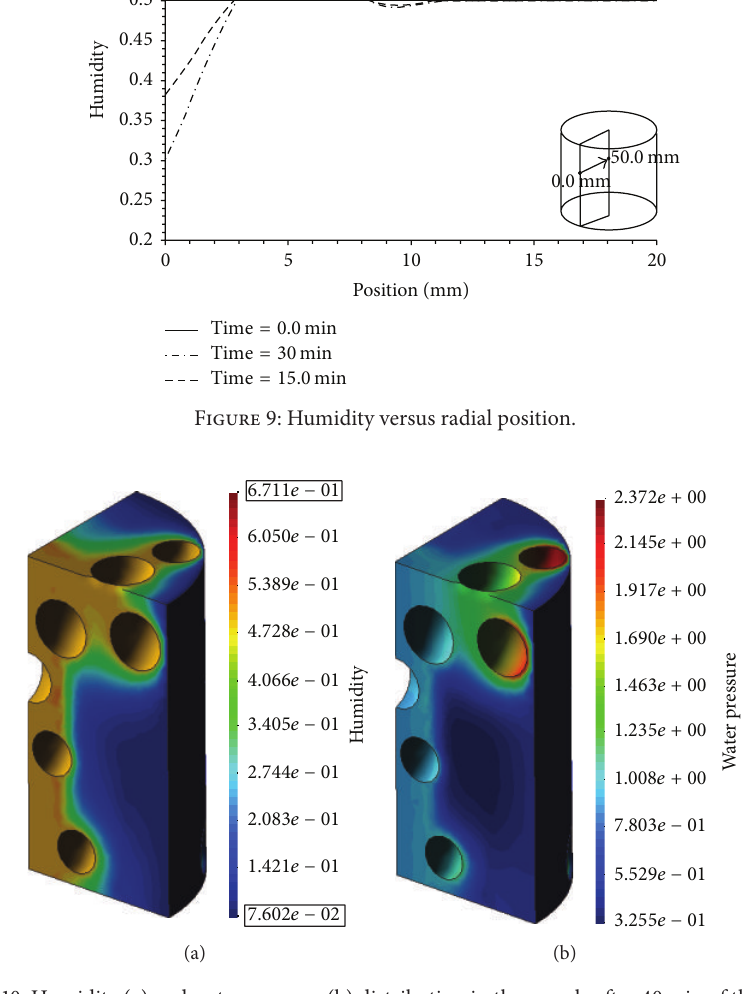
Figure 10: Humidity (a) and water pressure (b) distribution in the sample after 40 min of the